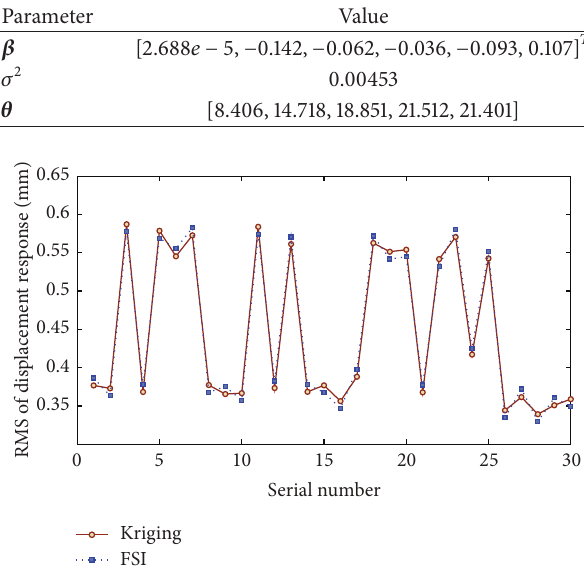
Figure 5: The results of RMS values at test